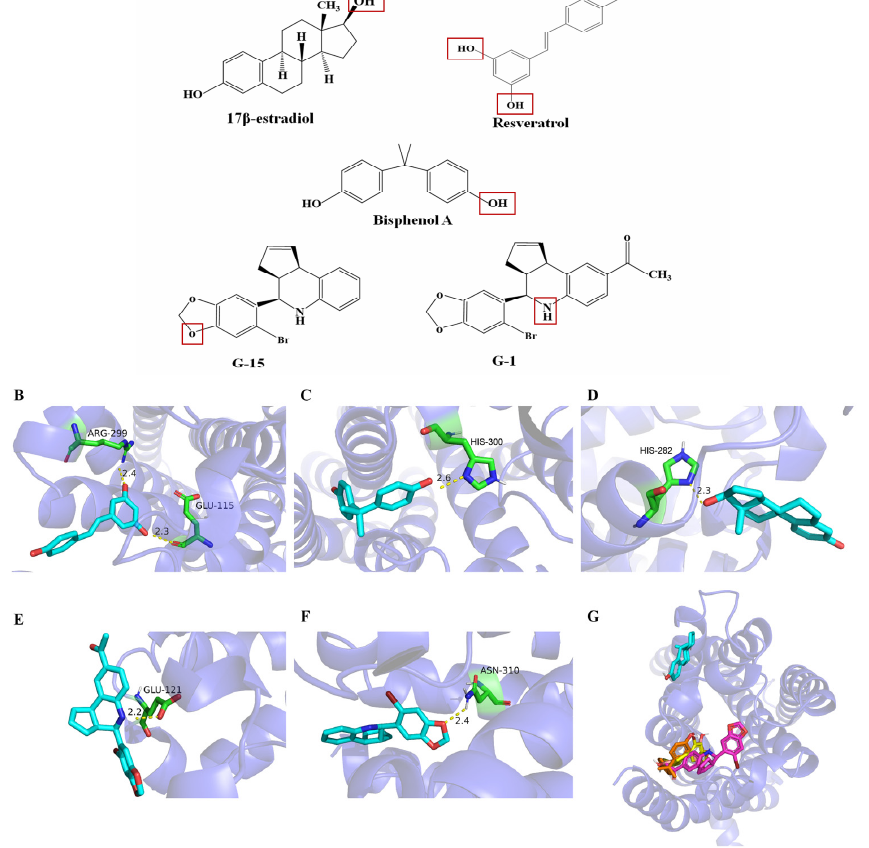
Figure 7. ( A ) Structures of GPER ligand compounds; 3D schematic diagram of molecular docking between GPER and fi ve estrogens and their analogs: ( B ) The residues Arg299 and Glu115 showed hydrogen bonding interactions with resveratrol with an interaction distance of 2.4 Å and 2.3 Å; ( C ) The residue His300 had hydrogen bonding interaction with bisphenol A with an interaction distance of 2.6 Å; ( D ) The residue His282 showed hydrogen bonding interaction with 17 β -estradiol with an interaction distance of 2.3 Å; ( E ) The residue Glu121 had hydrogen bonding interactions with G-1 with interaction distances of 2.2 Å; ( F ) The residue Asn310 had hydrogen bonding interactions with G-15 at an interaction distance of 2.4 Å; ( G ) Crystal structure of GPER and its binding sites with five estrogens and estrogen analogs: resveratrol (salmon); bisphenol A (orange); 17 β -estradiol (cyan); G-1 (magenta); G-15